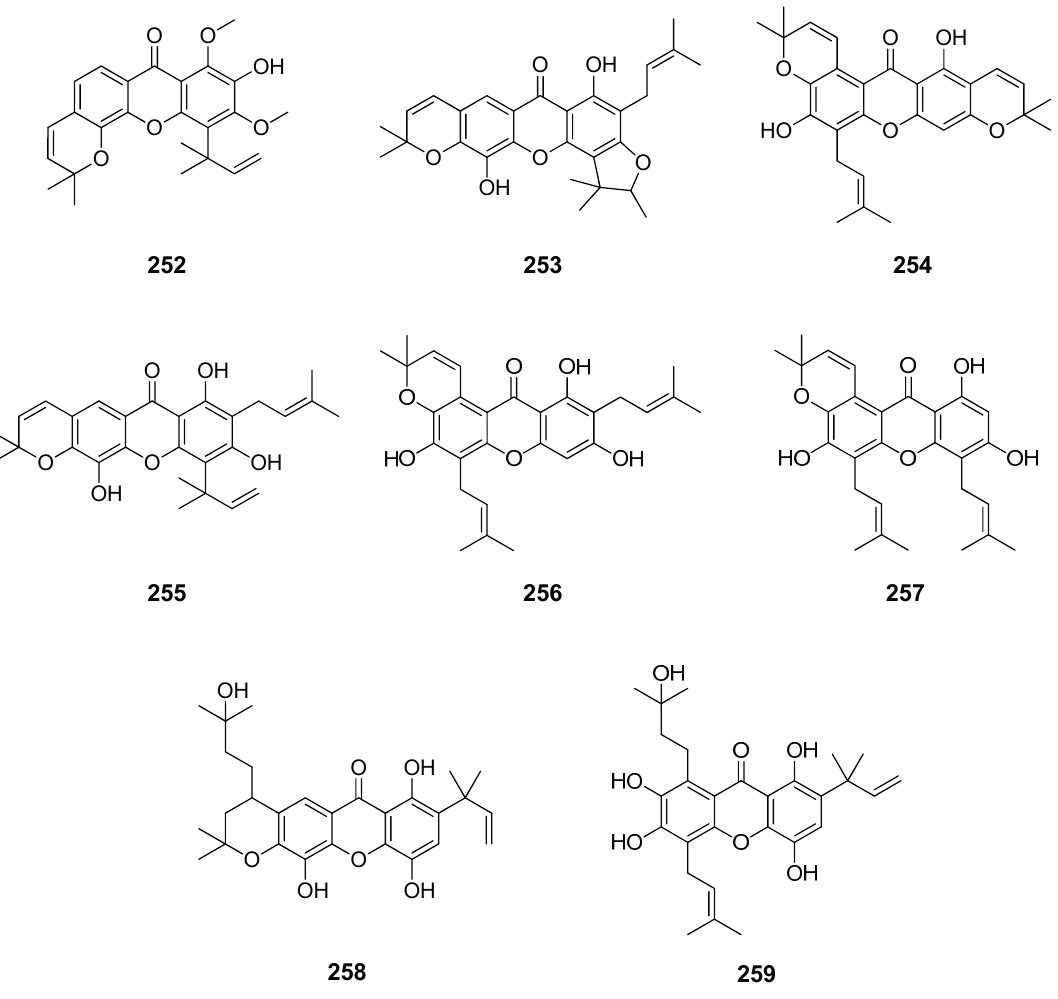
Figure 8. Chemical structures of tested tetraoxygenated and prenylated xanthones and cyclic derivatives.